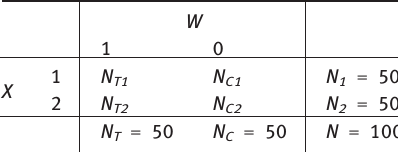
Table 3: Simulation design : We use a completely randomized design where N = 100 and N T =